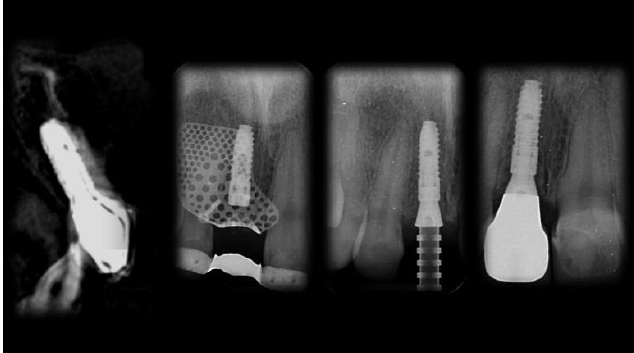
Figure 16. Intra- and extraoral lateral views 1 year after implant placement (2 months after definitive-restoration delivery).